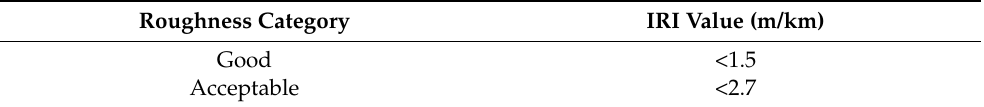
Table 3. FHWA IRI